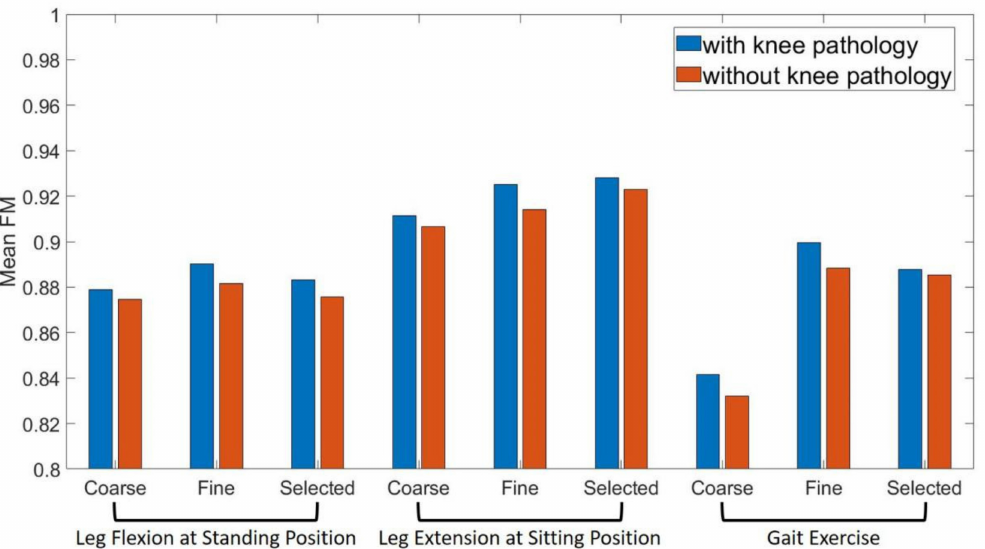
Figure 11. Mean F-measure of identifying subjects with or without knee pathology at different feature sets and lower limb